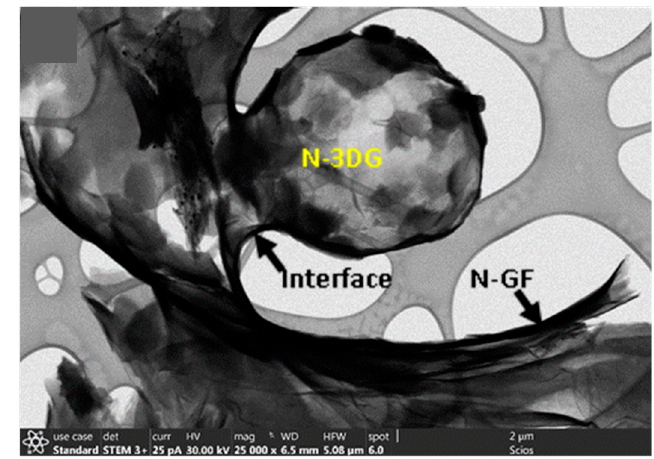
Figure 7. Scanning TEM (STEM) image of sample H2.